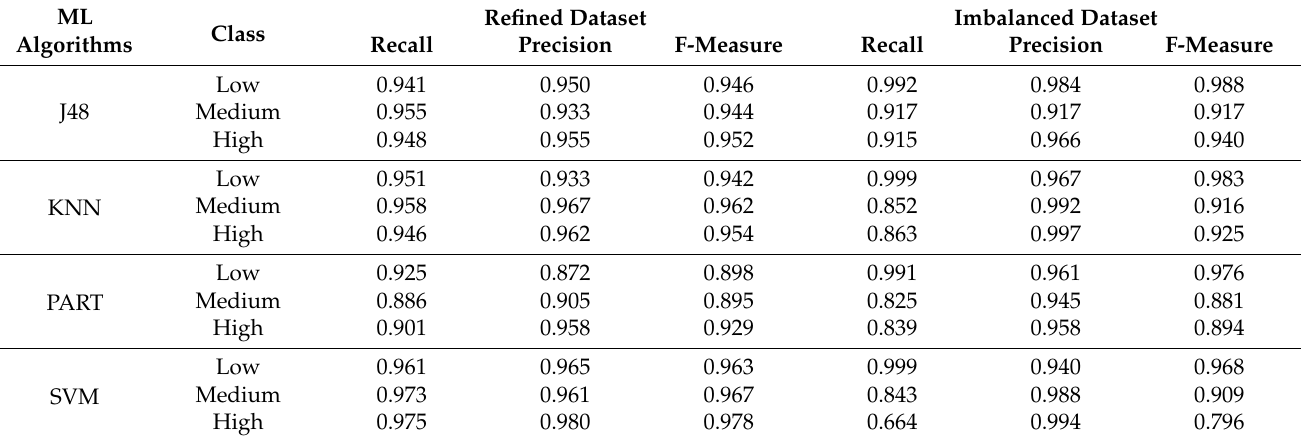
Table 3. Performance comparison between refined data and imbalanced data by ML algorithms.